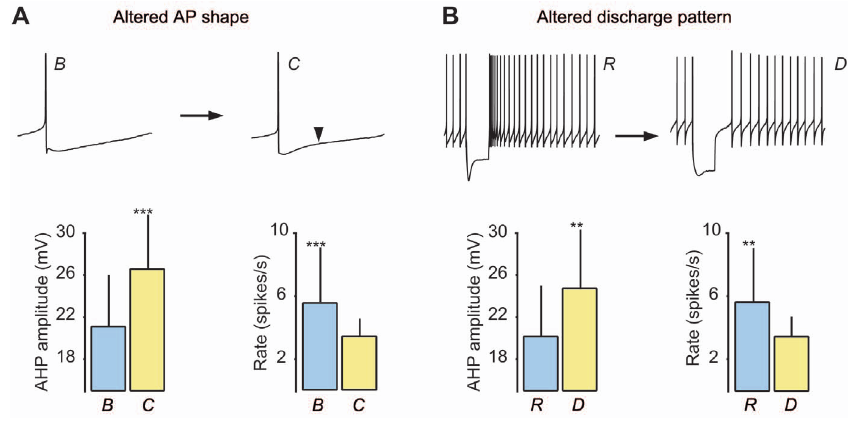
Figure 2 Homeostatic changes in MVN neuron excitability following attenuation of inhibitory drive. (A) The two action potentials (upper traces) depict a change in action potential shape from the ( B ) to the ( C ) phenotype in response to chronically reduced inhibitory drive. This change is hypothesized to come about as a result of the addition or unmasking of a rate-dampening ( I -like rectification; arrowhead) and manifests as alterations in excitability including larger AHPs and reduced discharge rates (bar plots). A (B) The two action trains (upper traces) depict a change in discharge pattern following release from hyperpolarization from the responsive ( R ) to the deficient ( D ) phenotype in response to chronically reduced inhibitory drive. As in (A) this change is characterized by enhanced AHPs and associated reductions in discharge rate (bar plots). Adapted from Camp et al.